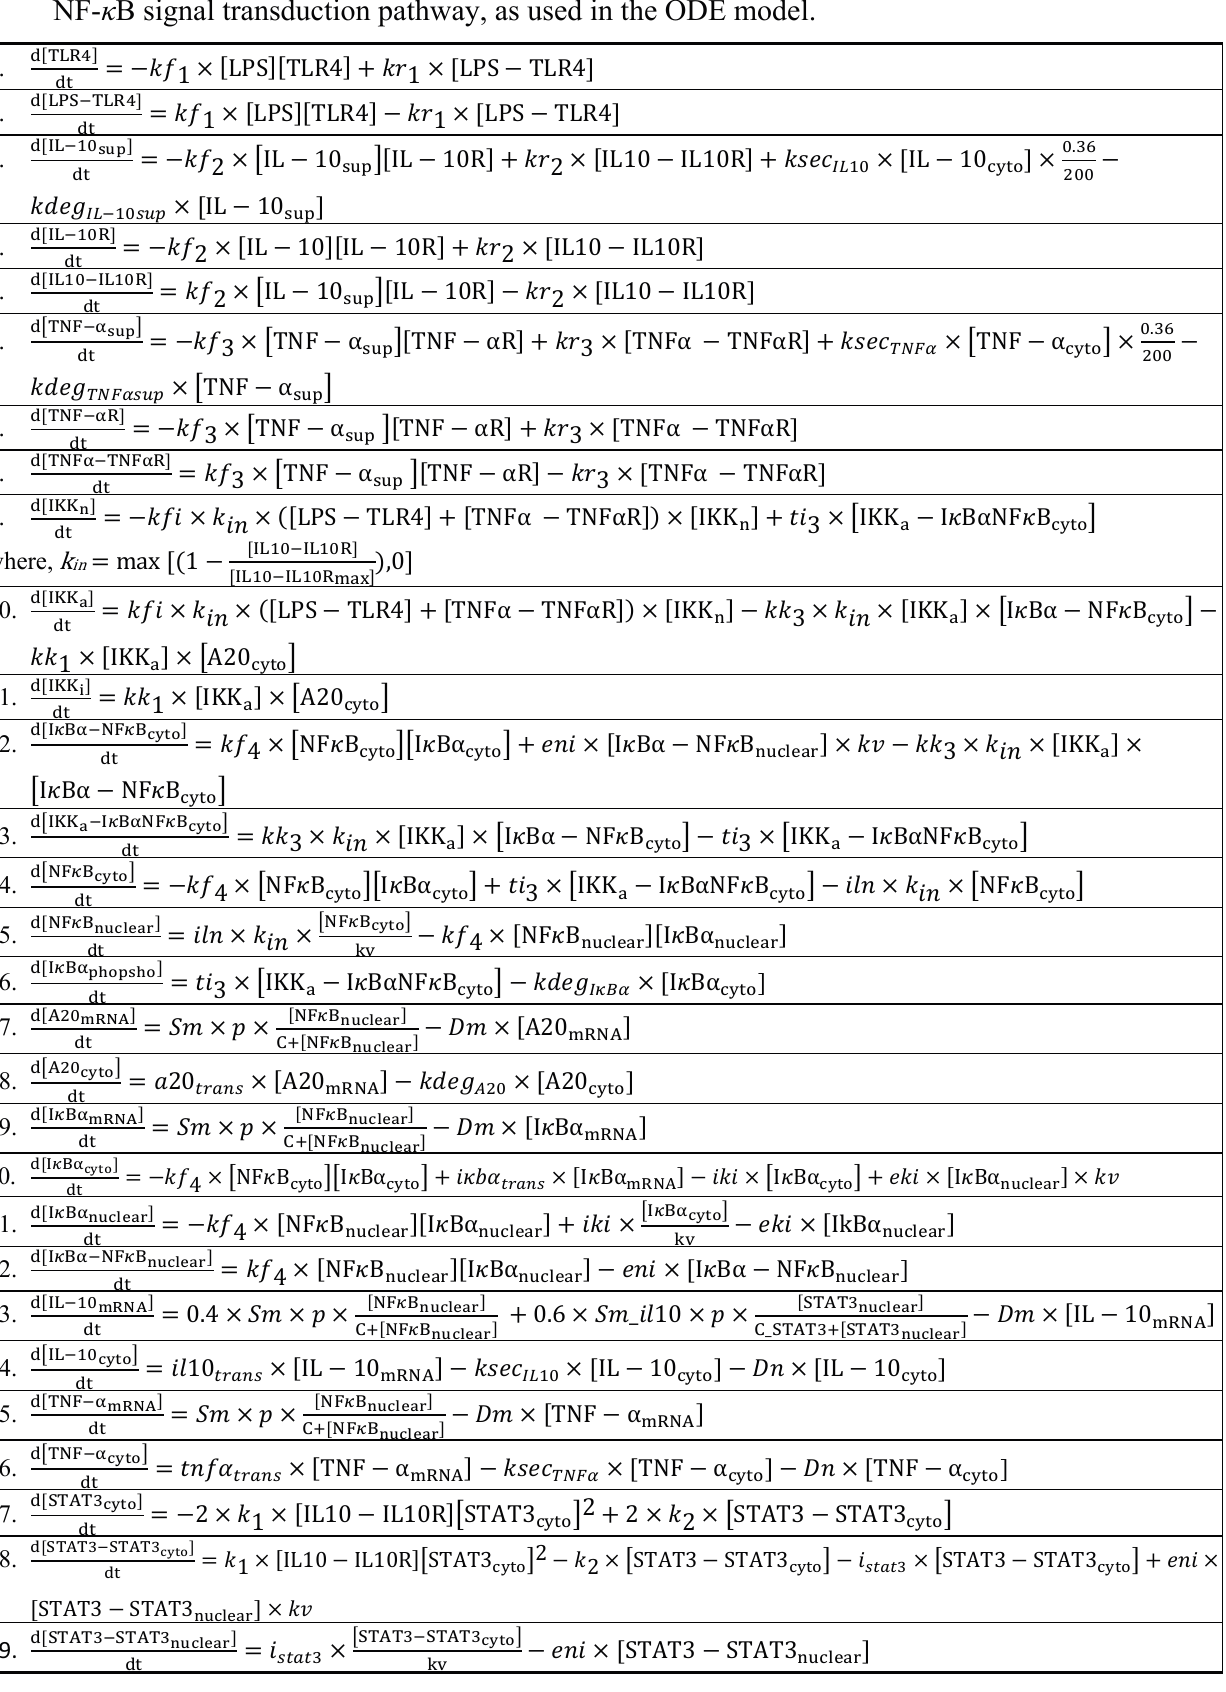
Table 1. Differential equations representing biochemical reactions involved in LPS-induced NF- κ B signal transduction pathway, as used in the ODE